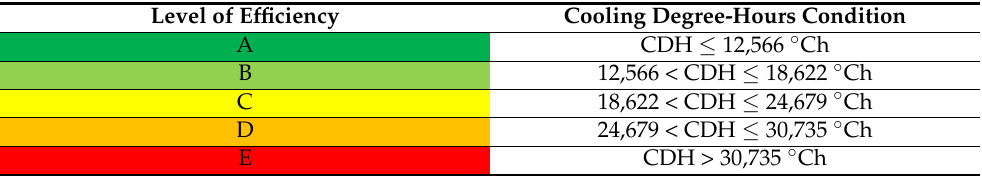
Table 5. Building envelope efficiency for the researched bioclimatic zone according to the Brazilian Technical Quality Regulation for Energy Efficiency Level of Residential Buildings